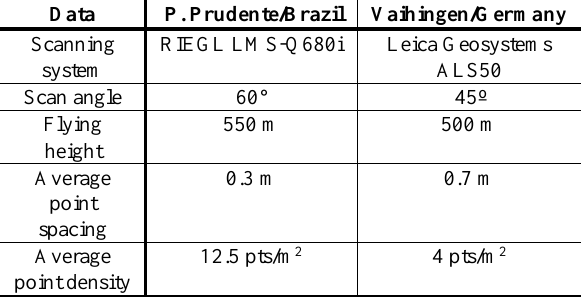
Table 1. Characteristics of the LiDAR datasets used in the